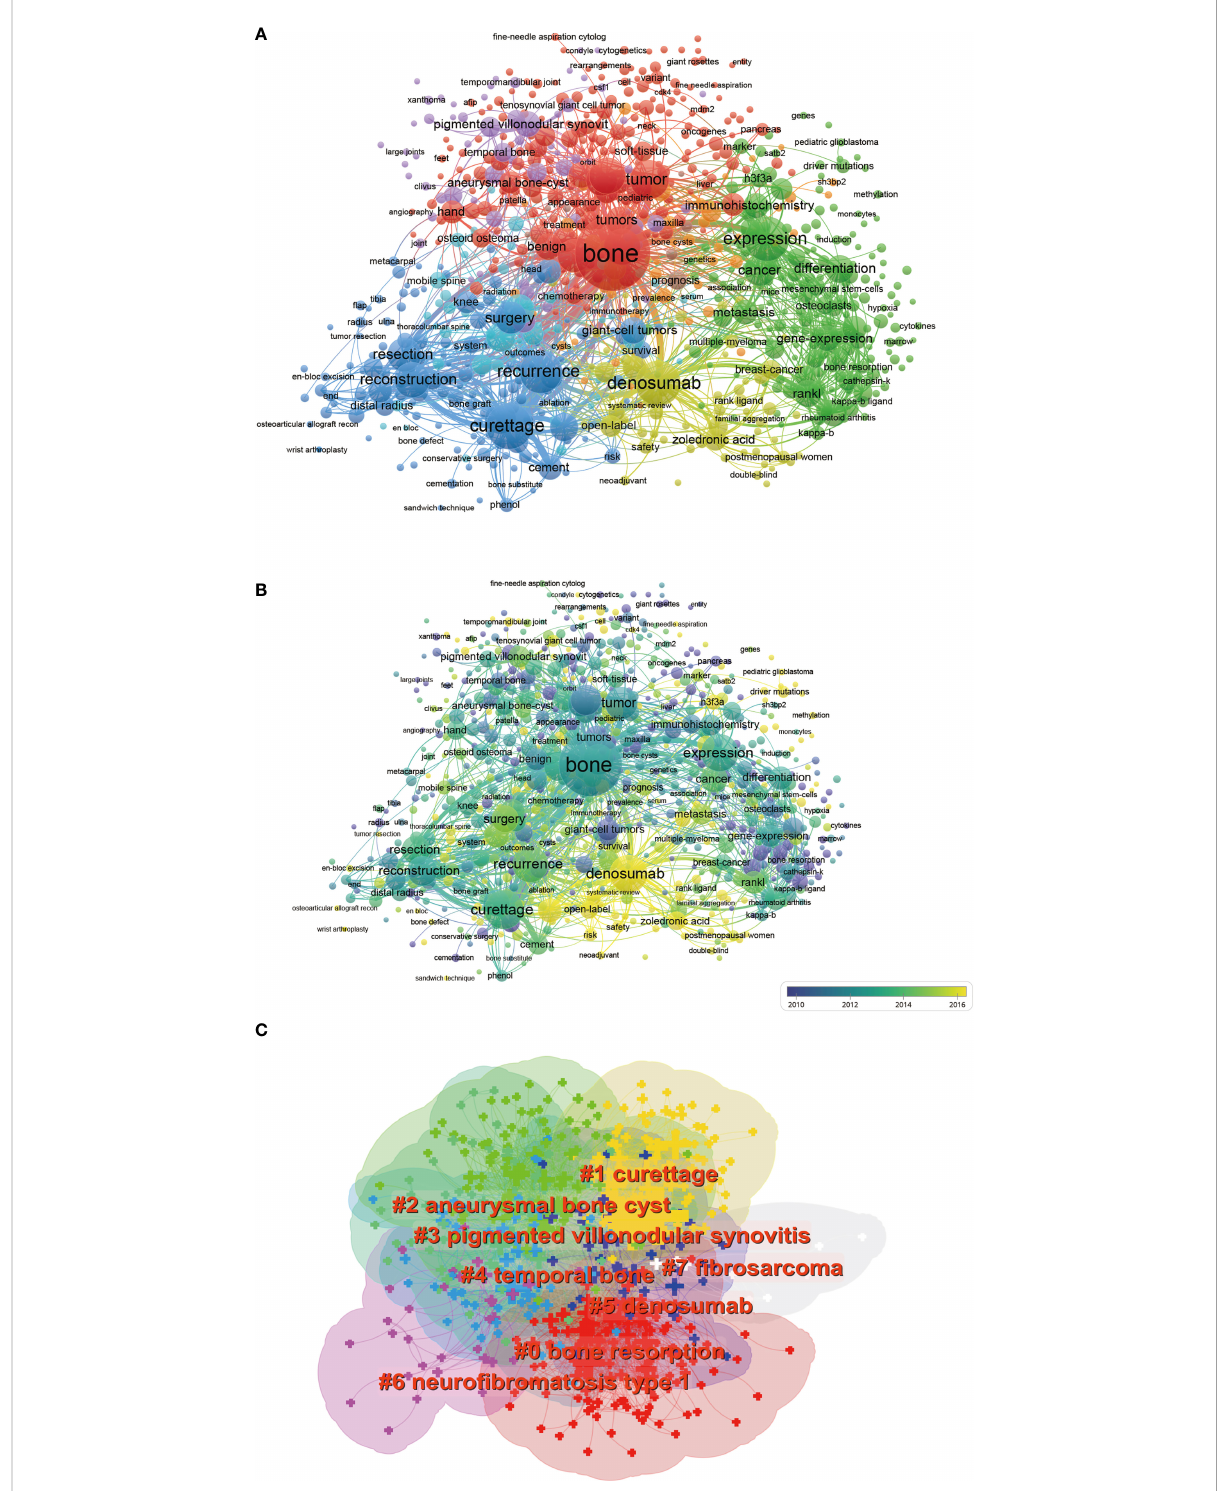
FIGURE 8 Visualization of co-occurrence analysis based on GCTB. (A) Mapping of keywords in the research on GCTB during 2001 – 2021; the frequency is represented by point size. (B) Distribution of keywords according to the mean frequency of appearance. Keywords in purple appeared earlier than those in green and yellow-colored keywords appeared later. (C) The keywords clustering knowledge map of GCTB during 2001 – 2021. Tag # was assigned to the cluster, and the smaller the number is, the more keywords are in the